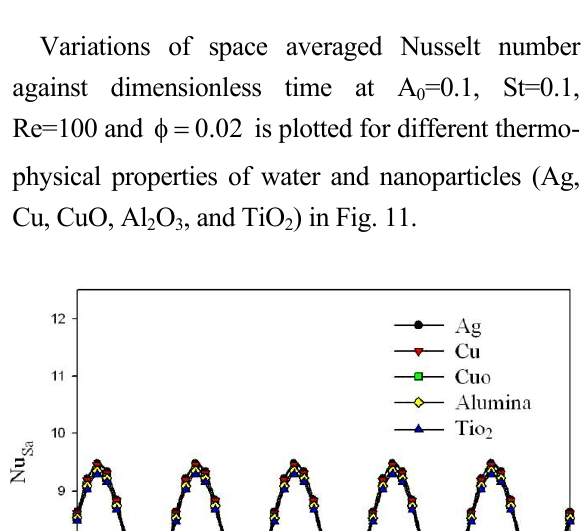
Fig. 10. Distribution of the total Nusselt number at =0.15 for different St and φ . A 0